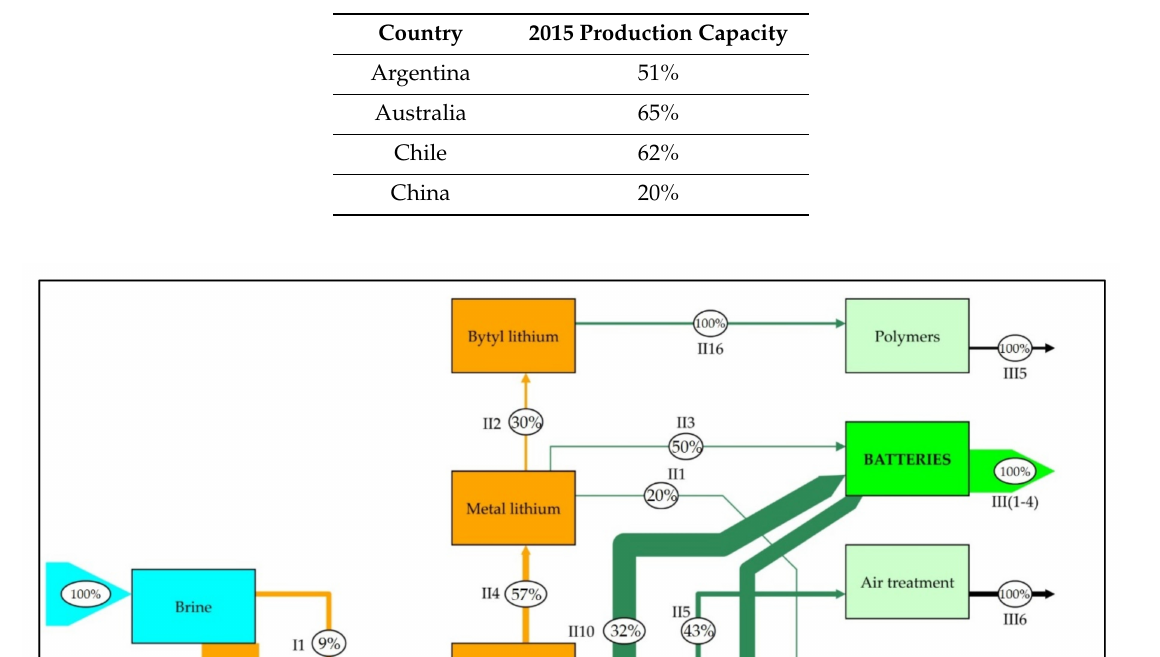
Table 1. Capacity utilization rate of countries that represent 92% of the global production at the resource mining stage [12,16].